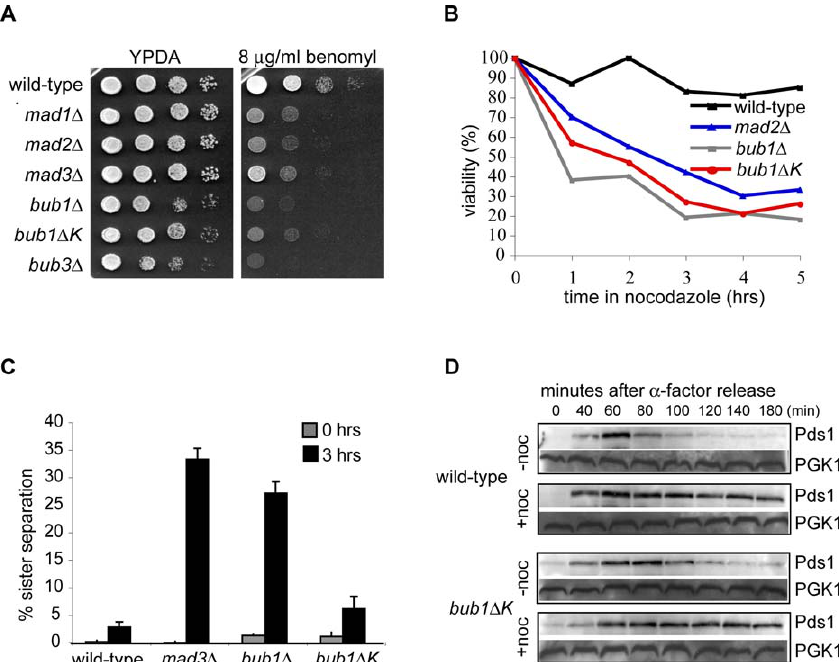
Figure 1. Cells Lacking Bub1 Kinase Domain Show Sensitivity to Microtubule Depolymerising Drugs despite Being Spindle Checkpoint Proficient (A) Wild-type (KH186), mad1 D (MB076), mad2 D (KH141), mad3 D (KH173), bub1 D (KH127), bub3 D (MB003), and bub1 D K (JF098) strains were plated out in 10-fold serial dilutions on YPDA media or on YPDA media containing 8 l g/ml benomyl. (B) The indicated strains were grown in YPDA media containing 30 l g/ml nocodazole, and the viability of the cells was measured as percentage of cells able to form colonies on YPDA media lacking microtubule drugs. (C) Wild-type (JF004), bub1 D K (JF125), bub1 D (JF140), and mad3 D (EK013) strains containing a GFP-marked chromosome were synchronised in G1 using a -factor, then released into YPDA with 30 l g/ml nocodazole at 23 8 C. We tested ability of the cells to maintain a spindle checkpoint arrest by scoring cells that could keep their GFP-marked sister chromatids cohesed for 3 h in nocodazole (i.e., one GFP dot). The percentage of cells with two GFP dots was counted at the release from G1 (grey bars) and after 3 h in nocodazole (black bars) ( n ¼ 100 cells for each repeat experiment). Error bars indicate standard deviation. (D) Wild-type (JF004) and bub1 D K (JF125) strains containing Pds1-18myc were arrested in G1 using a -factor and synchronously released into YPDA media or YPDA media containing 30 l g/ml nocodazole at 23 8 C. Samples were taken at indicated times. Levels of Pds1 were monitored